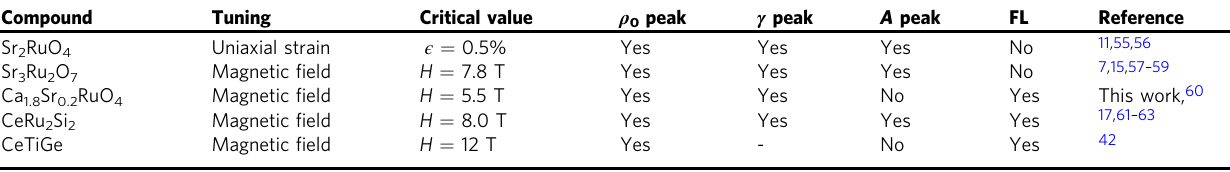
For each compound the tuning parameter (uniaxial strain ϵ or magnetic fi eld H) and the associated critical values are indicated. The behavior (peak or no peak) across the critical tuning of the temperature-independent term in resistivity ρ 0 , Sommerfeld coef fi cient γ , and electron – electron scattering coef fi cient A (see text) is indicated. Finally, the observed resistivity behavior (Fermi liquid or non-Fermi liquid) at the critical tuning and lowest measured temperature is